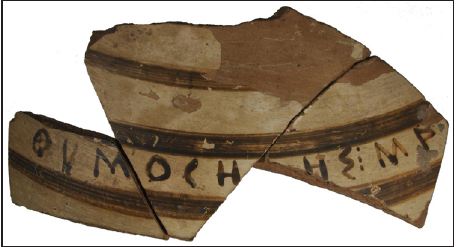
Fig. 5: British Museum GR1888,0601.173 + UCL-736. Chian bowl or lid. Max. dim. 30 cm. Courtesy of the Trustees of the